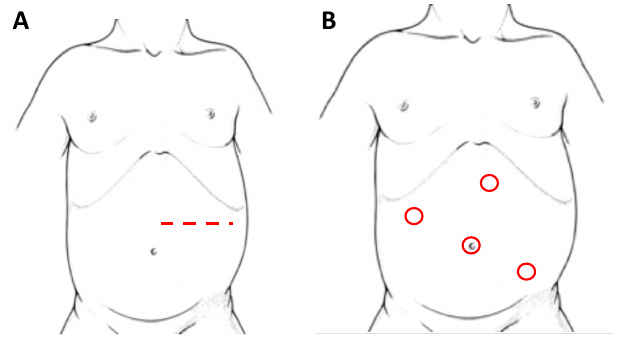
Figure 2. Patient’s position and site of incision/trocars in laparotomy ( A ) and laparoscopy ( B ), respectively, for left adrenal NBs.